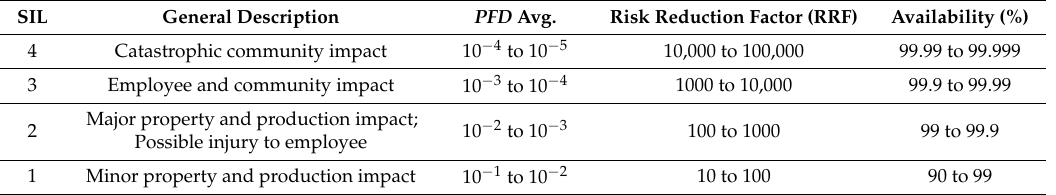
Table 5. Relationship between average probabilities of failure on demand to safety integrity levels (SIL). SIL General